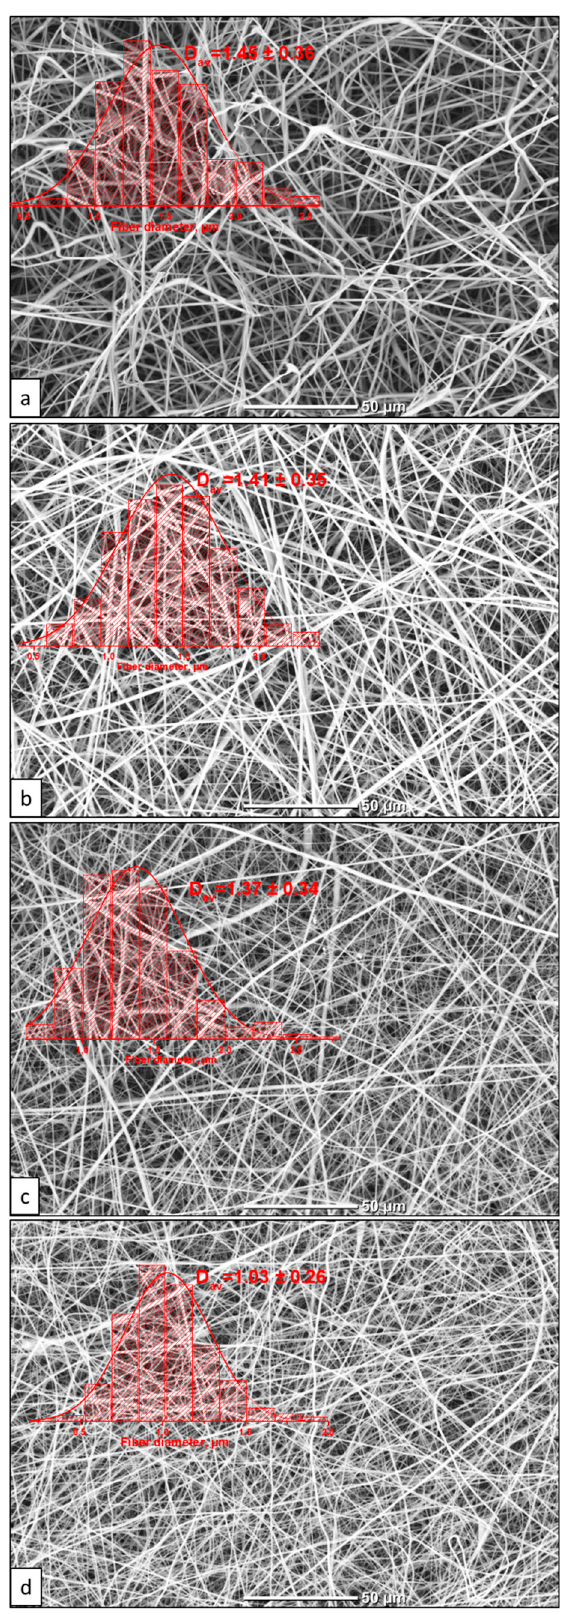
Figure 1. SEM images and fiber size distribution in the VDF–TeFE membranes with different